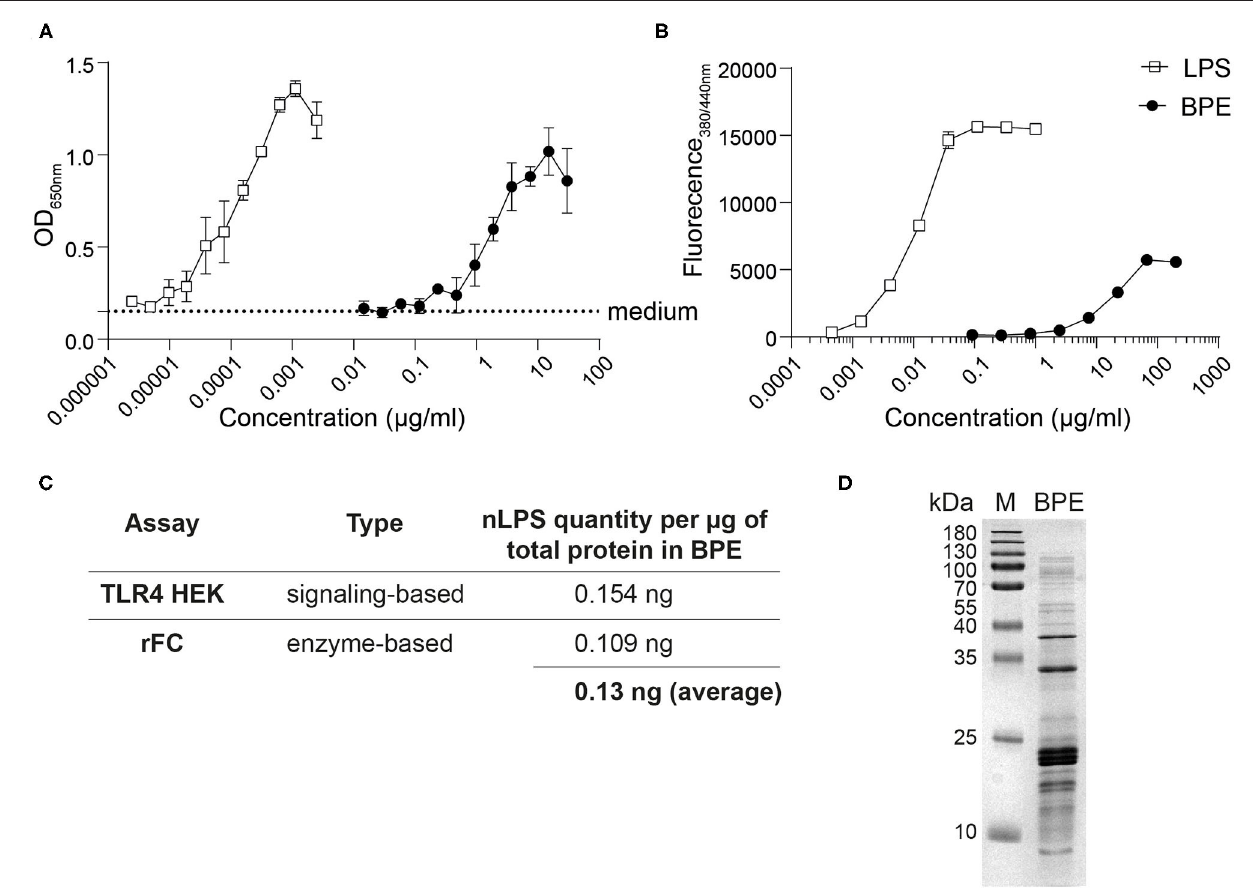
FIGURE 1 | Relative quantification of the LPS content in BPE. Titration curves of BPE (based on total protein concentration) and an LPS standard were performed using the mTLR4 HEK reporter assay (A) and the rFC endotoxin detection assay (B) in order to quantify the relative endotoxin level in BPE, using linear regression ( Supplementary Figure 1 ). Dotted line represents the average of medium-treated cells in (A) . Assays were performed in duplicates and repeated at least twice. Summary table showing the average amounts of nLPS determined in BPE for each method and the average of both approaches combined (C) . Coomassie Brilliant Blue-stained SDS-PAGE gel of BPE (D)